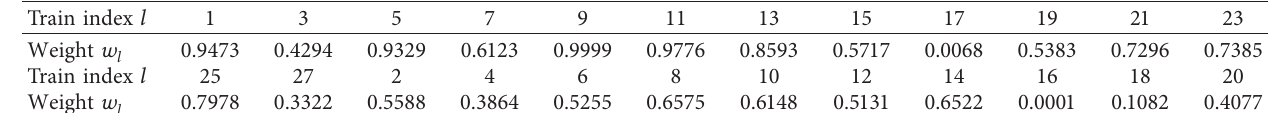
Table 3: The weight of each train.